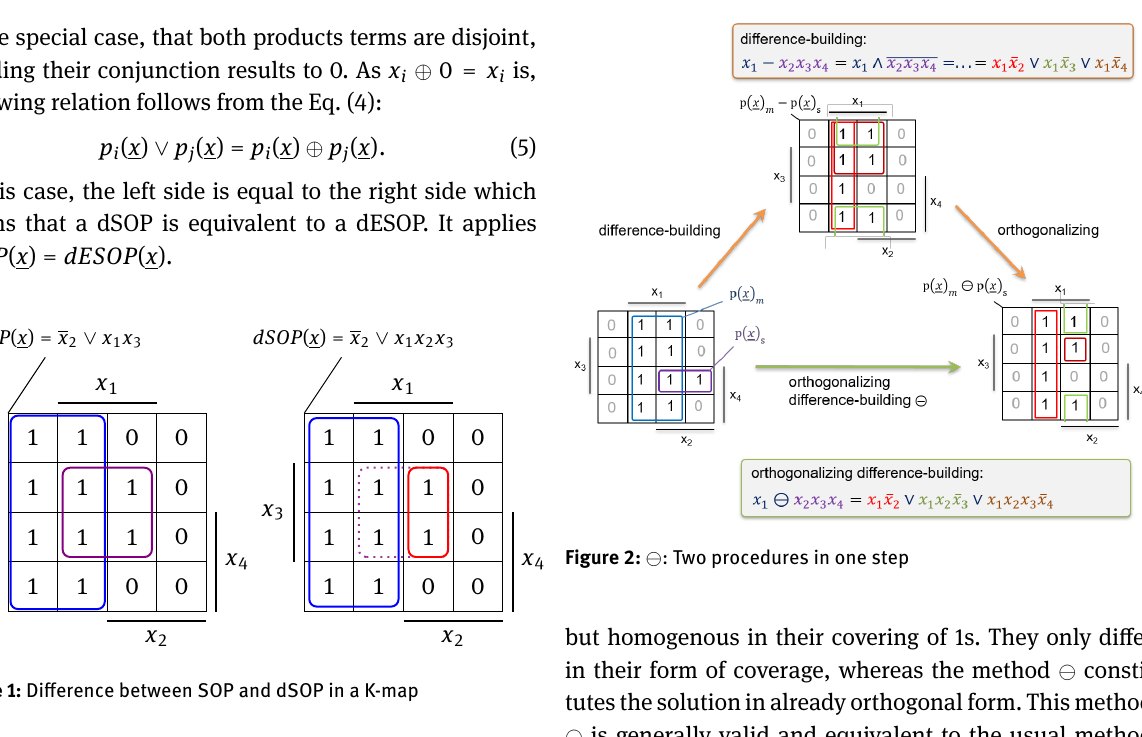
In a K-map a dSOP is characterized by non- overlapping cubes (Figure 1). Special calculations can